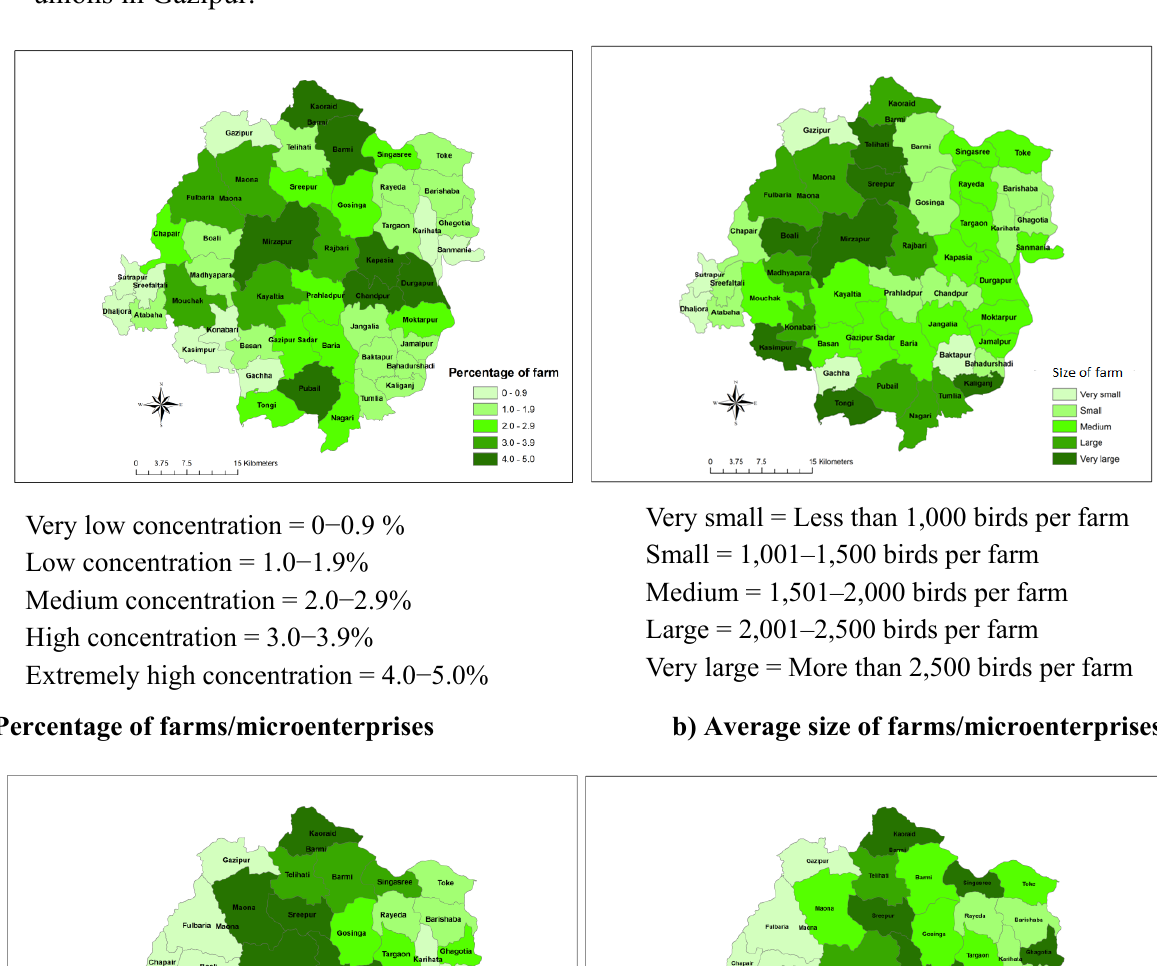
Figure 6. Geographic concentration of poultry farms/microenterprises by administrative unions in